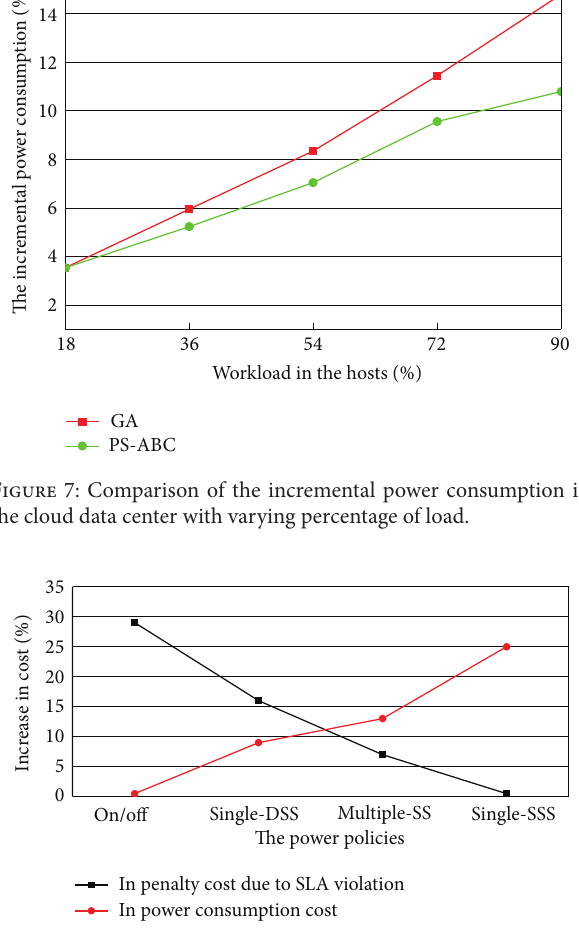
Figure 8: The trade-off between power and performance with different power management